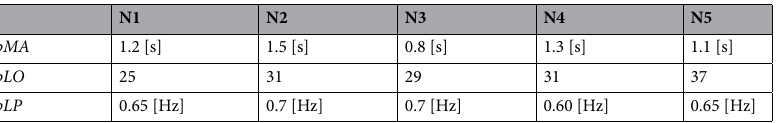
Table 1. Optimal filtering strength for each technique with the proposed framework. For pMA and pLO methods, the first number corresponds to the number of observed points, while the number in parenthesis corresponds to its equivalent in terms of